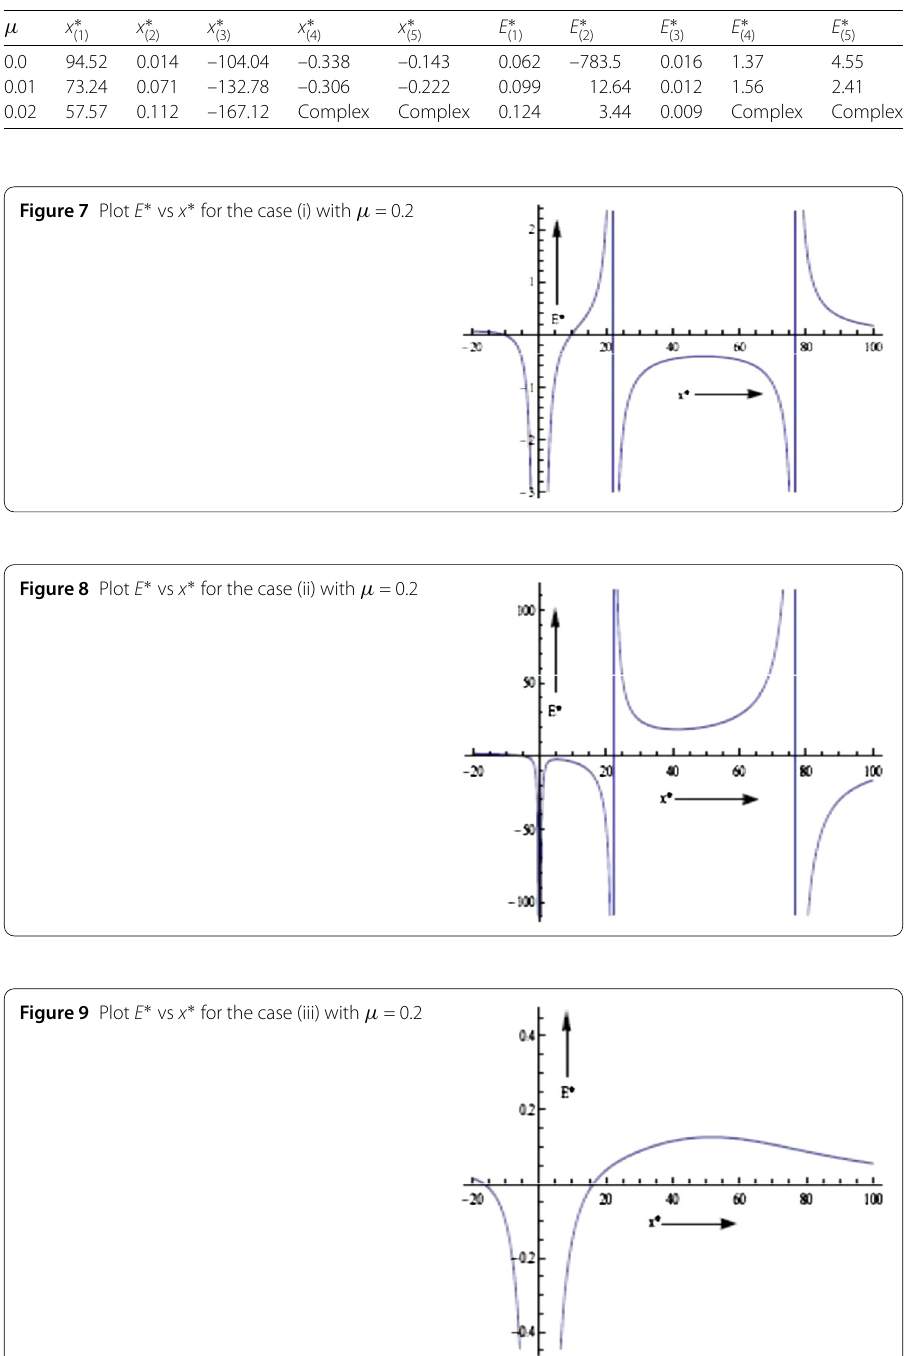
Table 4 Optimal singular solution for different discount rate μ